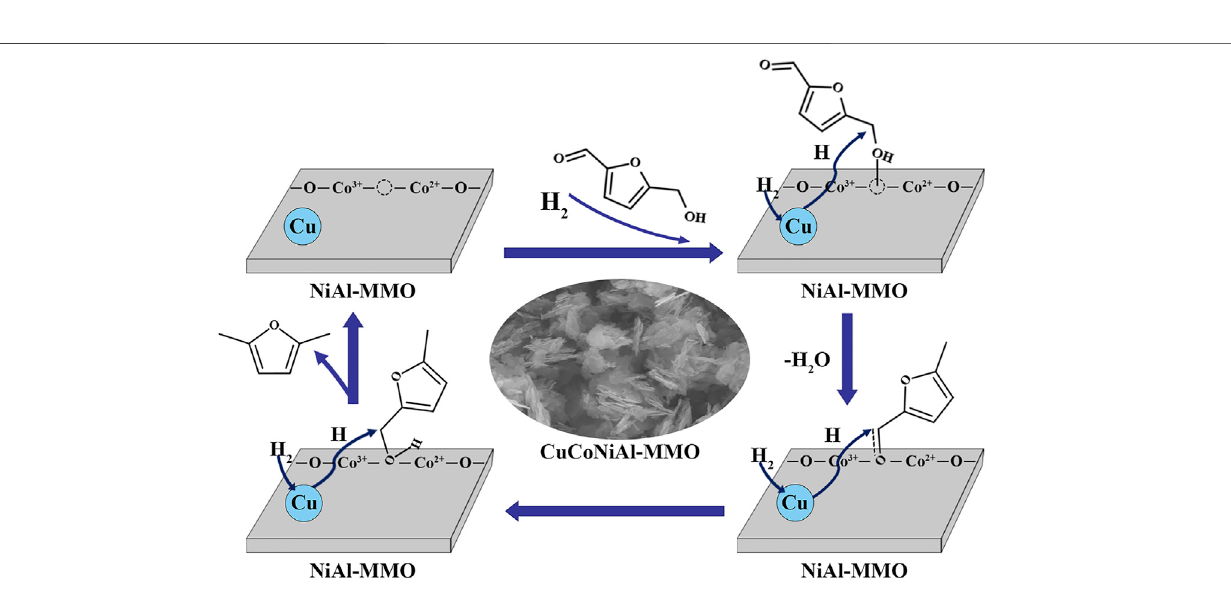
Frontiers in Chemistry |